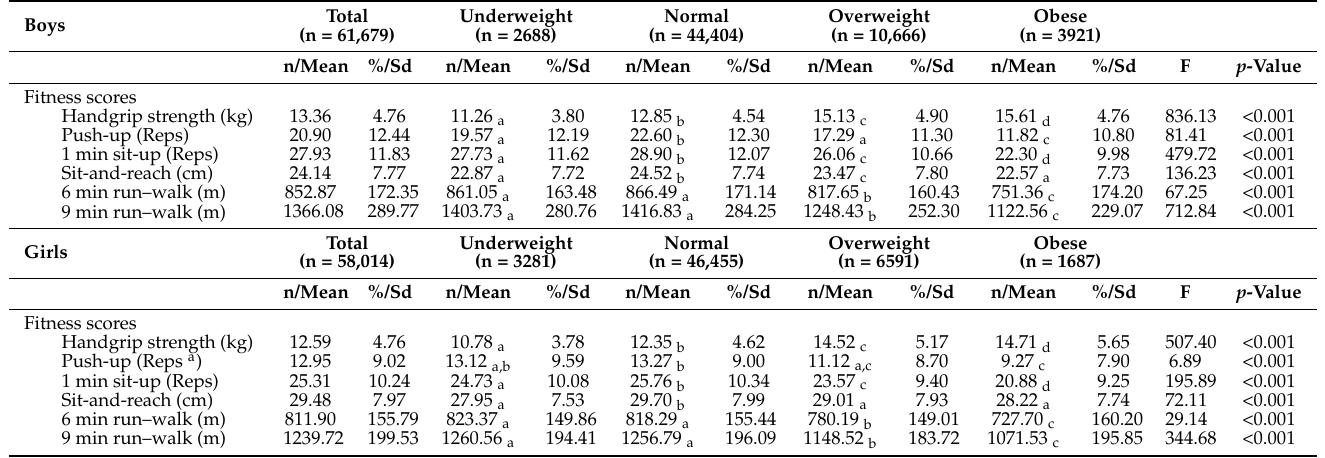
Table 2. Comparison of fitness test scores among BMI status